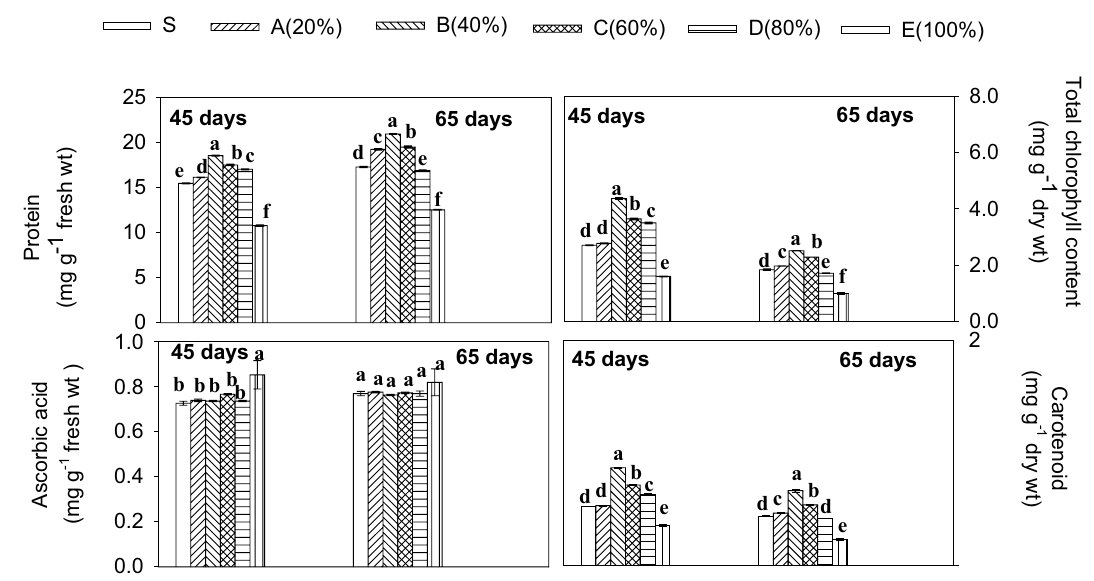
Fig. 1 Protein, ascorbic acid, total chlorophyll, and carotenoid content in lady’s finger plants grown at different MSWVC amendments at two dif-